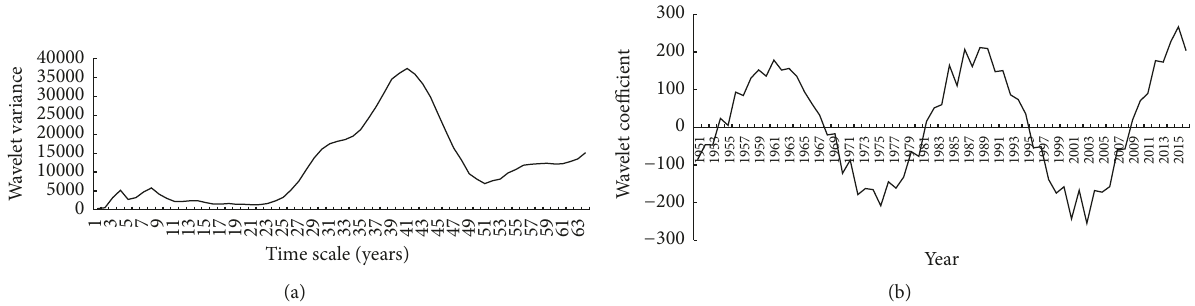
Figure 4: Wavelet variance and real part coefficient change in precipitation: (a) wavelet variance of precipitation; (b) real part coefficients change in precipitation on a 41-year